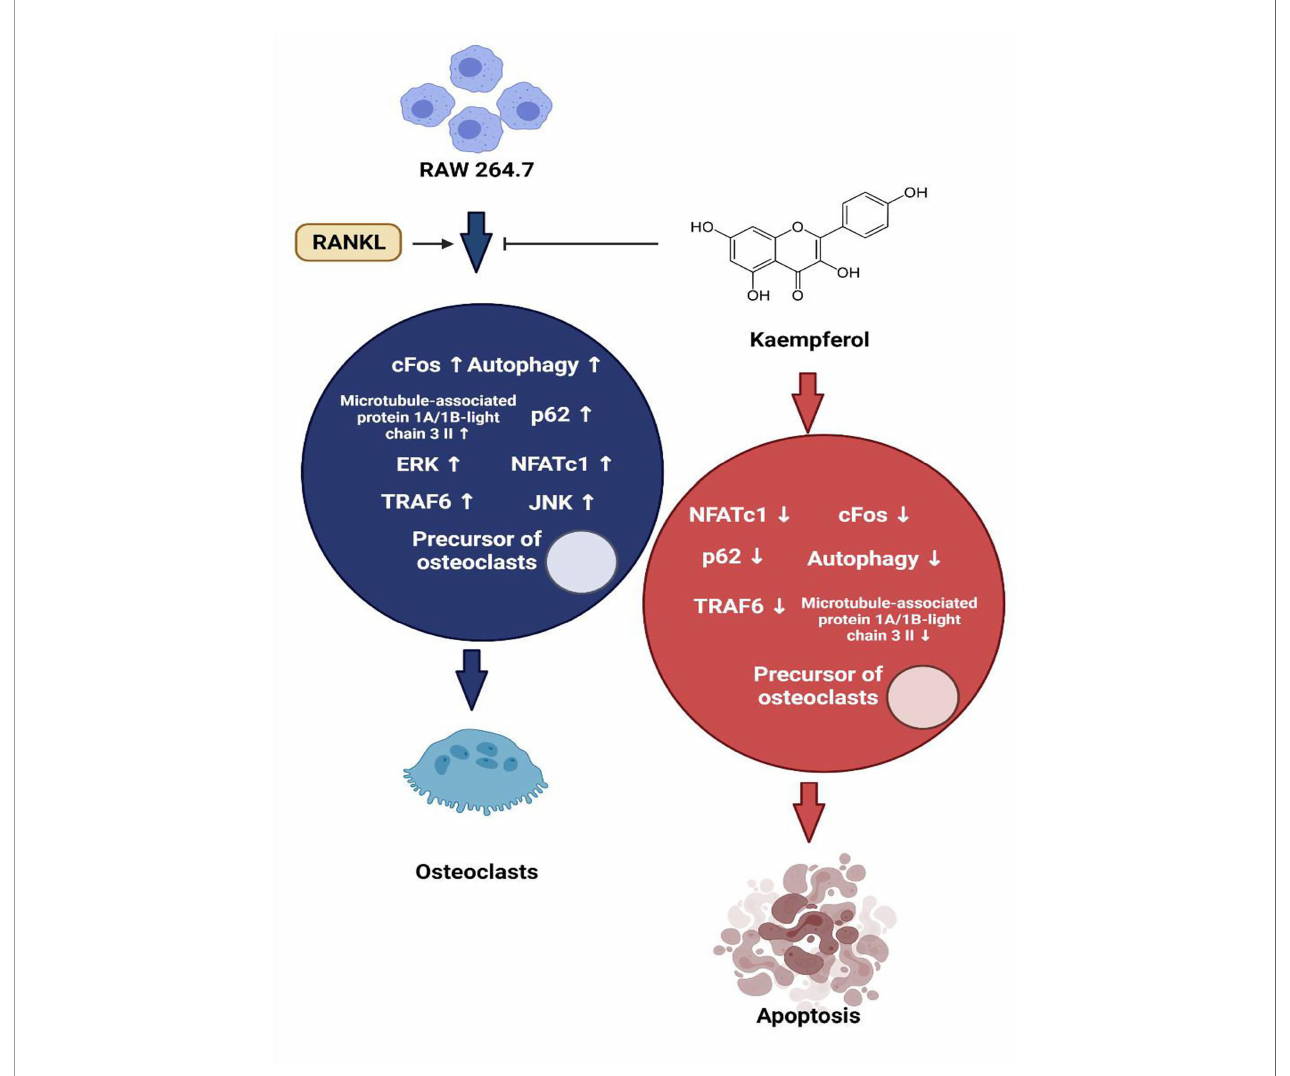
FIGURE 2 | Regulation of autophagy and apoptosis of osteoclasts by kaempferol via degradation of